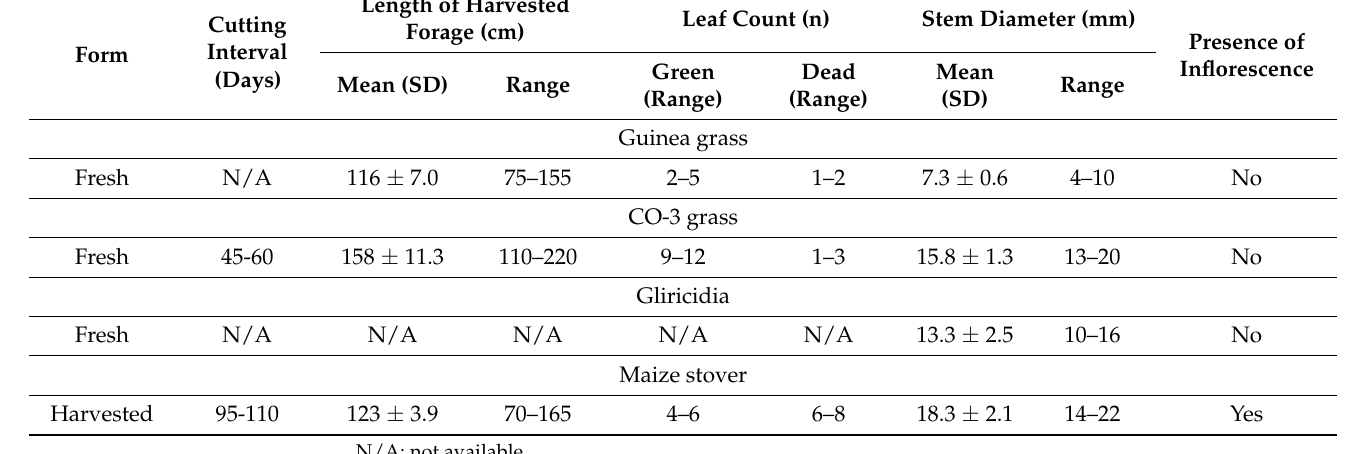
Table 1. Harvested length (mean ± standard deviation (SD), range), leaf count (green, dead), stem diameter (mean ± SD, range), and presence of inflorescence of forages used in the selected nine dairy farms in the Kurunegala district, Sri Lanka.